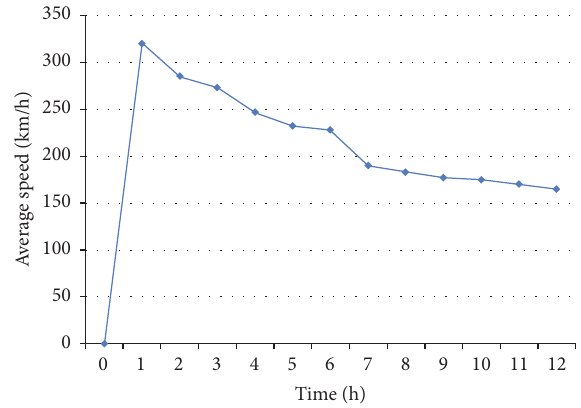
Figure 6: Average speed variation against time.